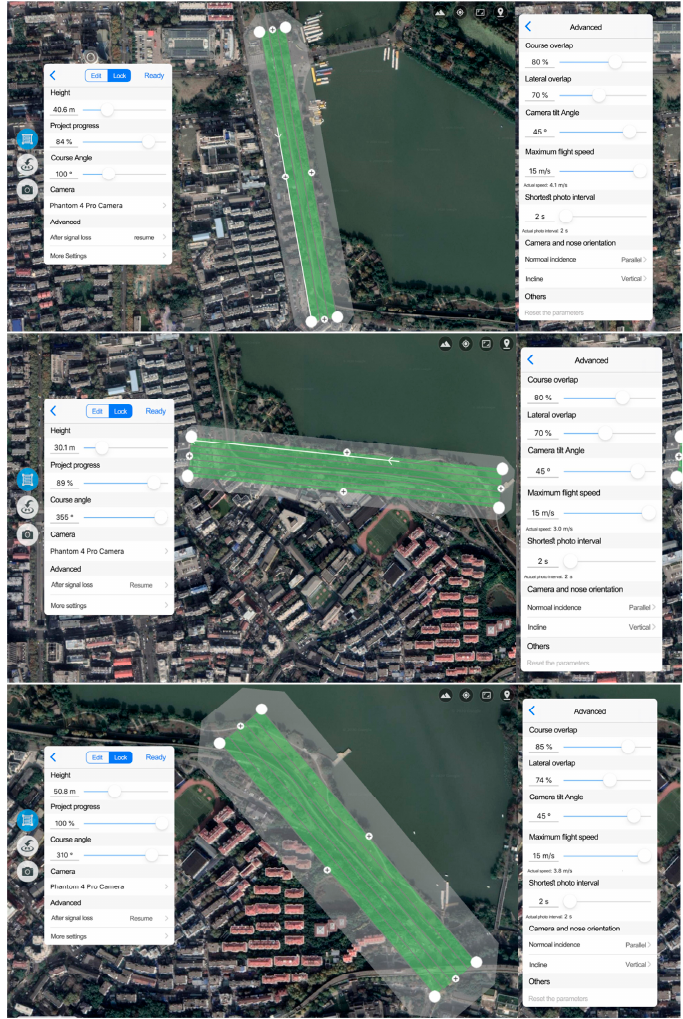
Figure 6. Route layouts and fl ight parameters of each of the three fl ights carried out by UAV.